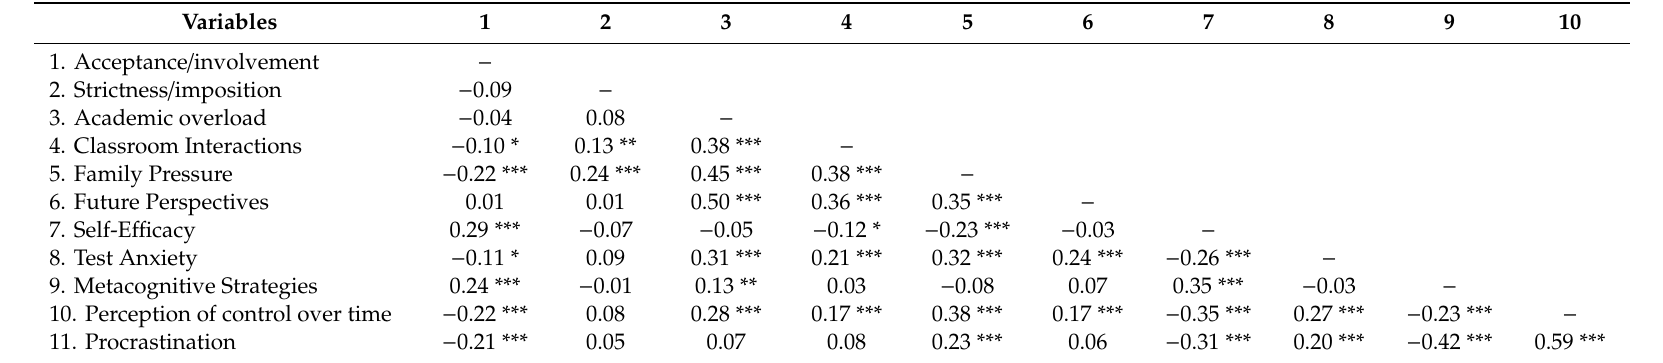
Table 1. Partial correlation matrix for all the study variables, controlling for sex and educational